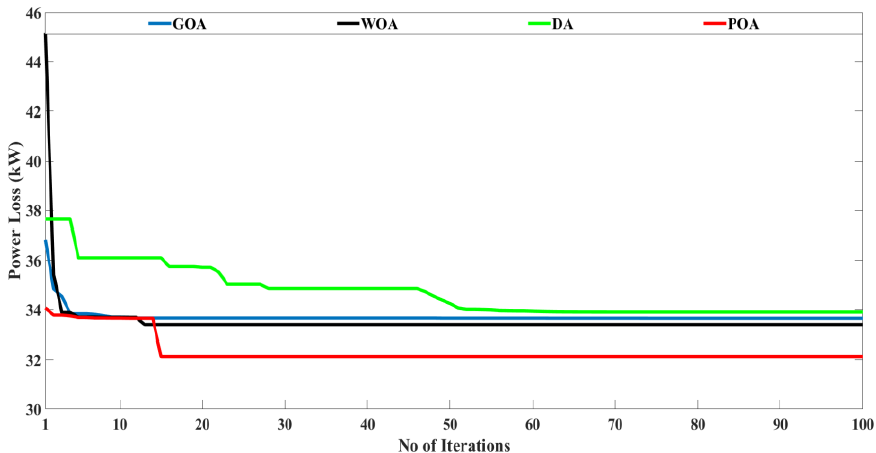
Figure 13. POA Comparisons with Other methods.